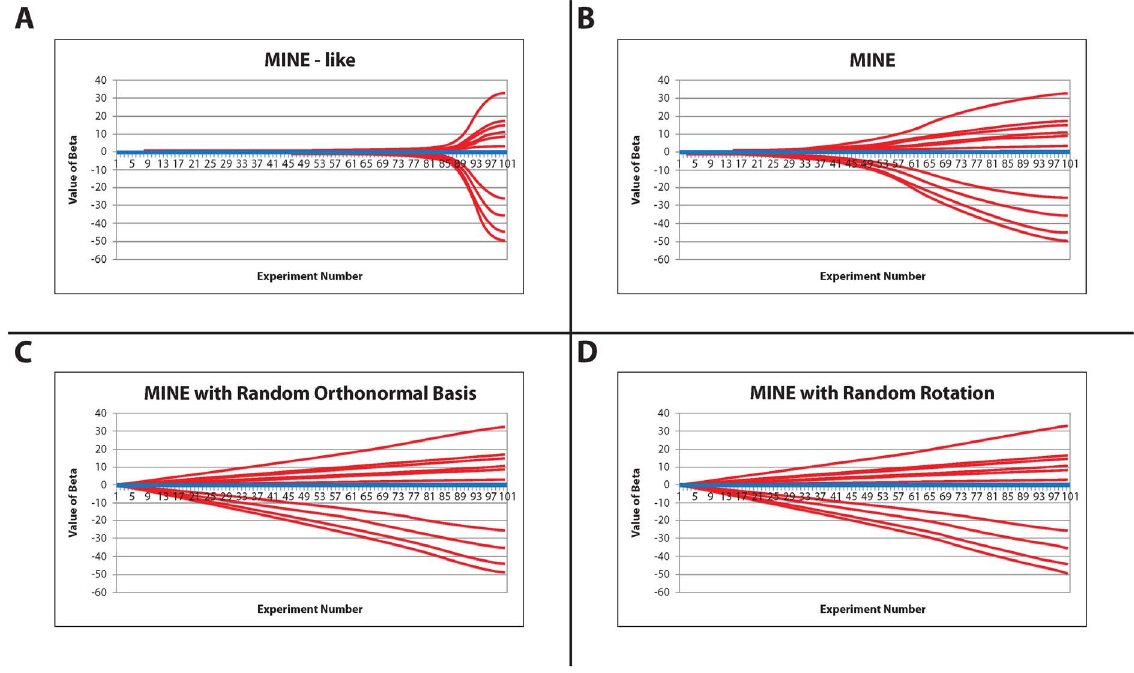
Figure 4. Posterior means of the first 20 regression coefficients as a function of the number of experiments for: (A) the MINE-like method; (B) MINE method; (C) MINE method with random orthonormal basis; (D) MINE method with random rotation. Each panel is averaged over all 1000 simulations with 10 zero (in blue) and 10 nonzero (in red). The first ten (red) are truly nonzero.